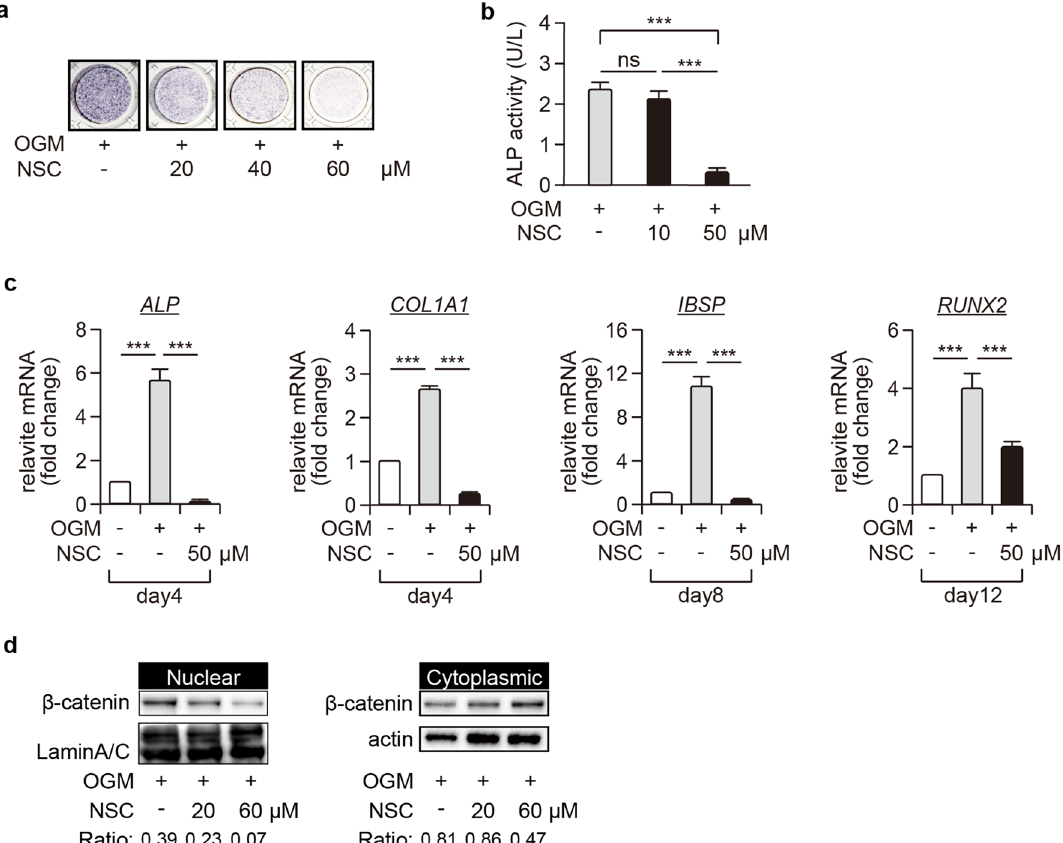
Figure 4. Inhibition of RAC1 disrupts nuclear β-catenin translocation and osteogenic differentiation of pGCTB-SCs. ( a ) NSC23766 (NSC), a selective RAC1-GEF inhibitor, decreased ALP expression levels in GCTSCs in a concentration-dependent manner. pGCTB-SCs were differentiated in OGM with or without NSC for 6 days, and ALP staining was subsequently performed. ( b ) pGCTB-SCs were cultured with or without 10 μM or 50 μM NSC for 6 days, and ALP activity was determined by measuring OD 405 . Values represent means ± SD (n = 4). *** P < 0.001. ns, not significant. ( c ) NSC also diminished expression of osteoblastic markers, ALP , COL1A1 , IBSP, and RUNX2 . Cells were cultured with or without 50 μM NSC for the indicated periods, and the mRNA levels were investigated by qRT-PCR. Values represent means ± SD (n = 4). *** P < 0.001. ( d ) NSC decreased the OGM-induced nuclear β-catenin translocation. pGCTB-SCs were pre-treated with 20 μM or 60 μM NSC for 12 h and further incubated with OGM for 12 h. β-catenin was analyzed in the nuclear and cytoplasmic fractions by western blotting. Experiments were repeated three times, and representative images were Tartrate‑resistant acid phosphatase (TRAP) staining for GCTB‑OCs. FFPE sections (not exposed to denosumab) were deparaffinized, rehydrated, and incubated with adjusted solutions for 15 min at 37 ℃ according to the manufacturer’s protocol (TRAP/ALP staining kit, Fujifilm Wako) for the detection of TRAP activity of GTCB-OCs. The stained sections were washed three times with deionized water and counterstained with Methyl Green Solution (FUJIFILM Wako) for 5 s. Denosumab-exposed tissue samples were also stained as negative controls. Co‑labeling assay for H3G34W and RUNX2.